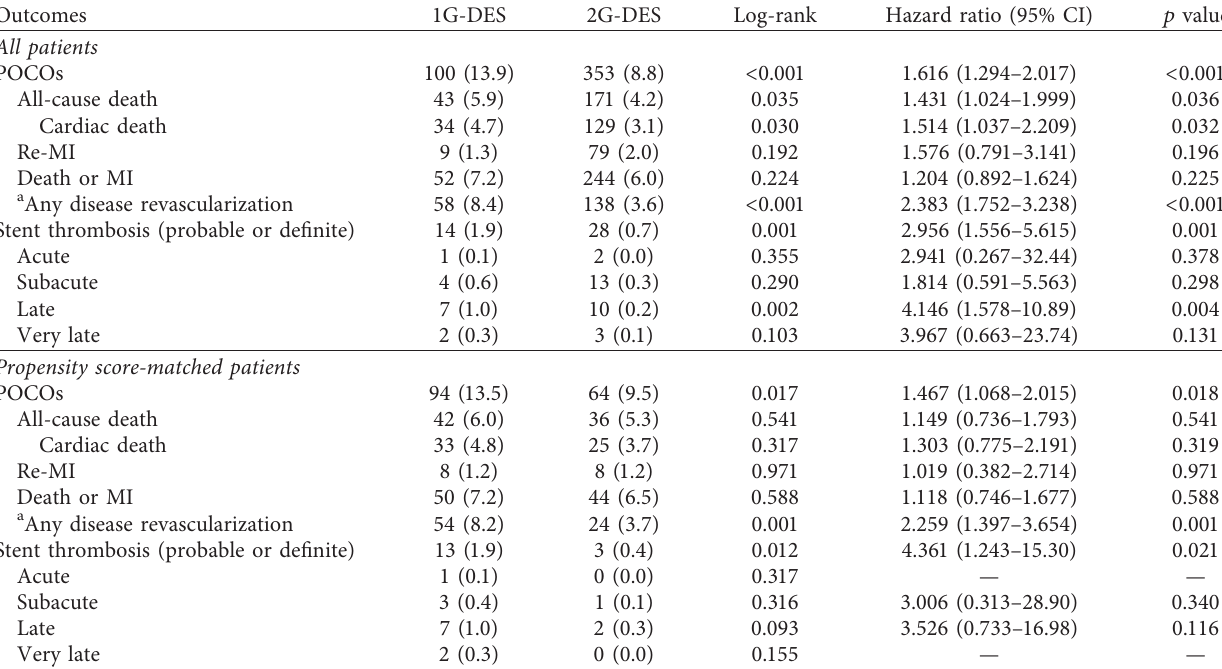
Table 2: Clinical outcomes by Kaplan–Meier analysis and Cox proportional hazard ratio analysis at 2 years.